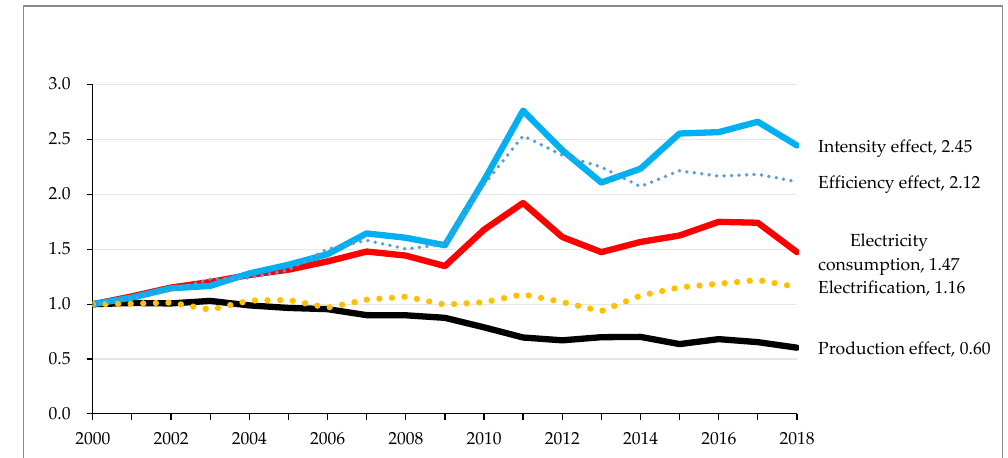
Figure A10. Mining and quarrying electricity consumption LMDI results (fixed base year, multipli- cative).